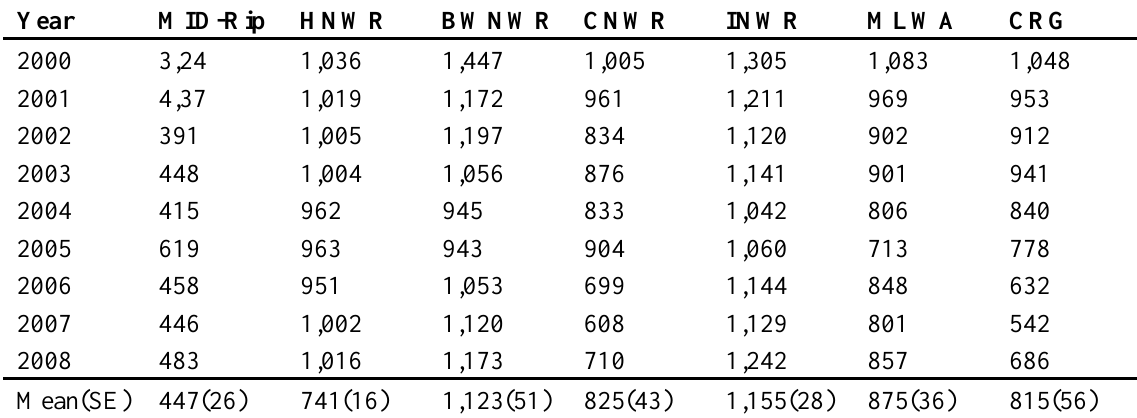
Table 3. ET estimates (mm yr −1 ) for riparian areas on the Lower Colorado River based on Enhanced Vegetation Index from MODIS satellite sensors and ground measurements of ETo. MID-Rip = riparian vegetation north of the Mohave Irrigation District; HNWR = Havasu National Wildlife Refuge; BWNWR = Bill Williams National Wildlife Refuge; CNWR = Cibola National Wildlife Refuge; MLWA = Mittry Lake Wildlife Area; CRG = confluence of the Colorado and Gila rivers at Yuma, Arizona. Year MID-Rip HNWR BWNWR CNWR